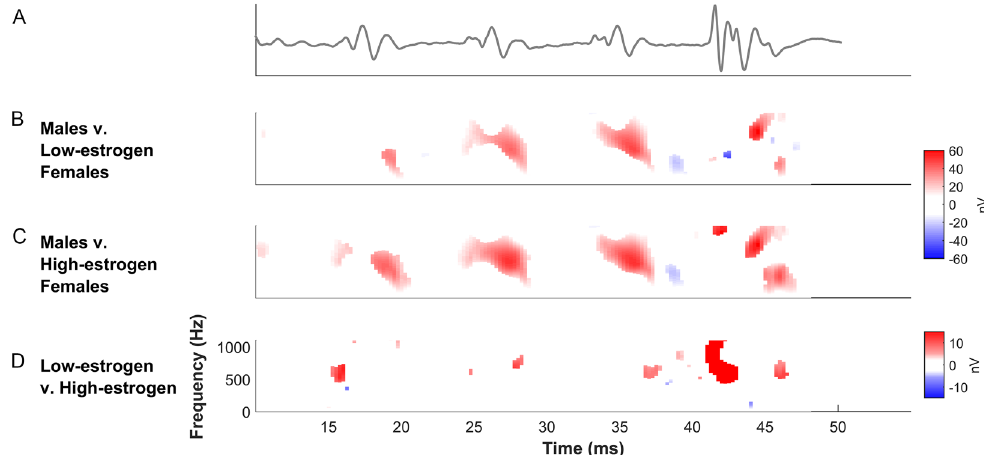
Figure 2. Spectrotemporal differences between males and females. For ( B ) and ( C ), red indicates greater energy at the given time and frequency for females and blue is greater energy for males. In ( D ), red corresponds to greater activity during estrus/proestrus and blue is for diestrus/metestrus. The top FFR waveform ( A , gray) is zoomed in over the region of interest (16.5–43.5 ms). During this region, the larger peaks occurring every ~ 8.3 ms correspond to the periodicity of the fundamental frequency of the sound. These regions also correspond to where differences in harmonic encoding between males and metestrus/ diestrus ( B ) and proestrus/estrus ( C ) exist. The temporal alignment of the fundamental periodicity and the harmonic enhancement suggest that the harmonic enhancement also provides females with greater tracking of the fundamental frequency. In contrast, the differences in harmonic encoding across the estrous cycle are most concentrated toward the end of the response ( D ), which suggests that sound boundaries are processed more robustly during